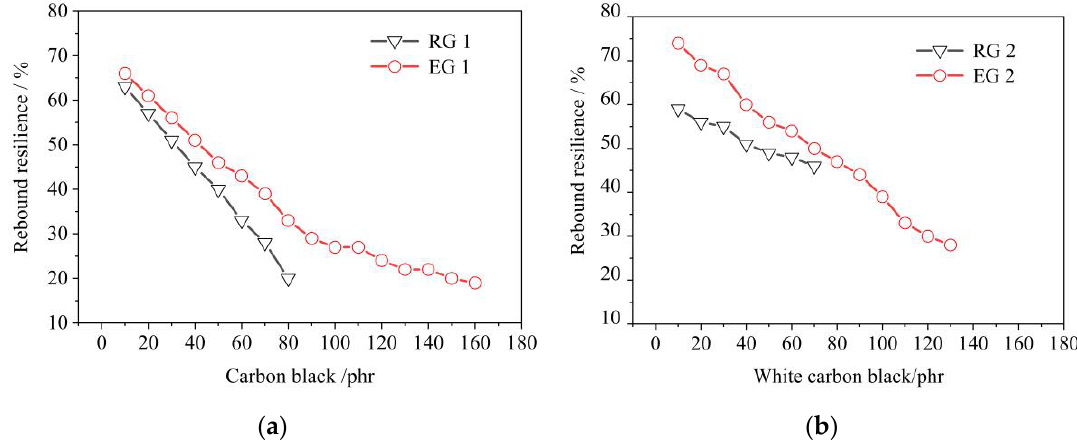
Figure 5. Effect of filler on the rebound resilience of rubber samples. RG 1 and EG 1 were for SBR rubber mixtures; RG 2 and EG 2 were rubber mixtures based on NR rubber. ( a ) Effect of CB on the rebound resilience of rubber samples; ( b ) Effect of WCB on the rebound resilience of rubber samples.